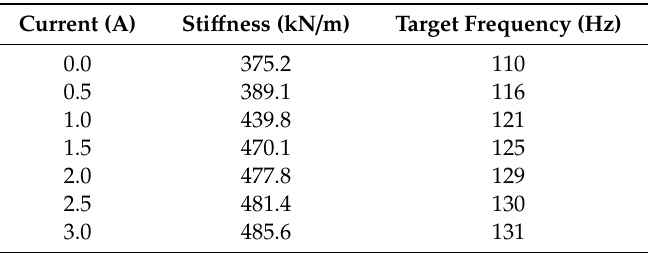
Figure 20. Shear deformation of magnetorheological elastomer. Table 5. Sti ff ness measurement of magnetorheological elastomer due to current.